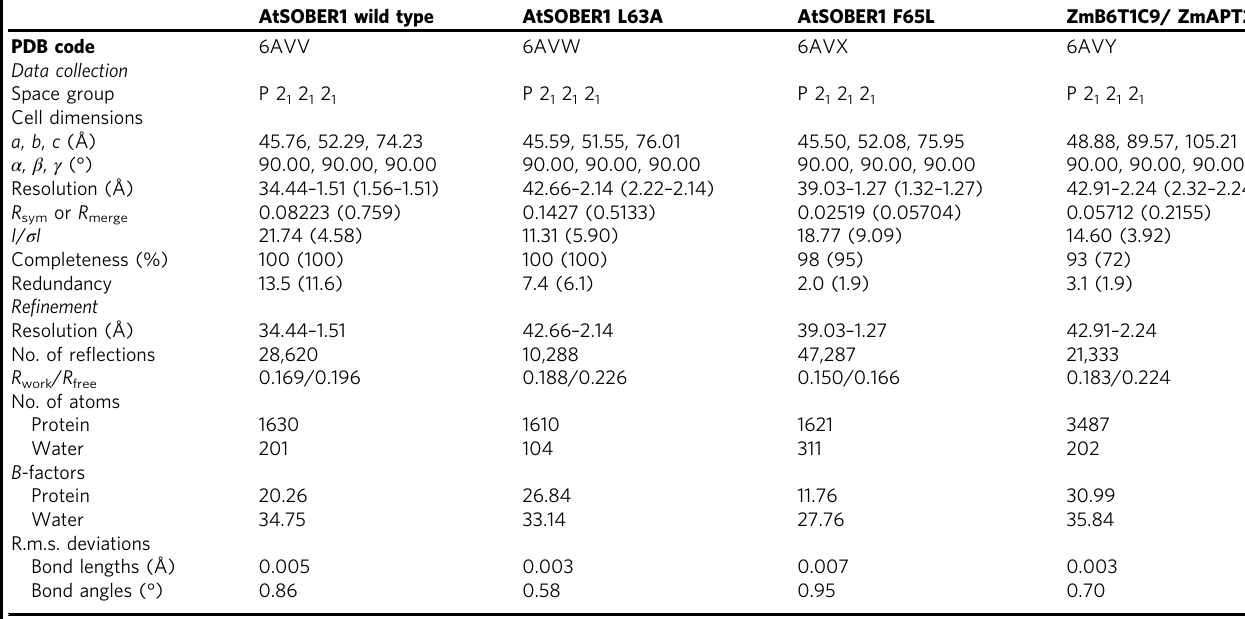
Table 1 Data collection and re fi nement statistics (molecular